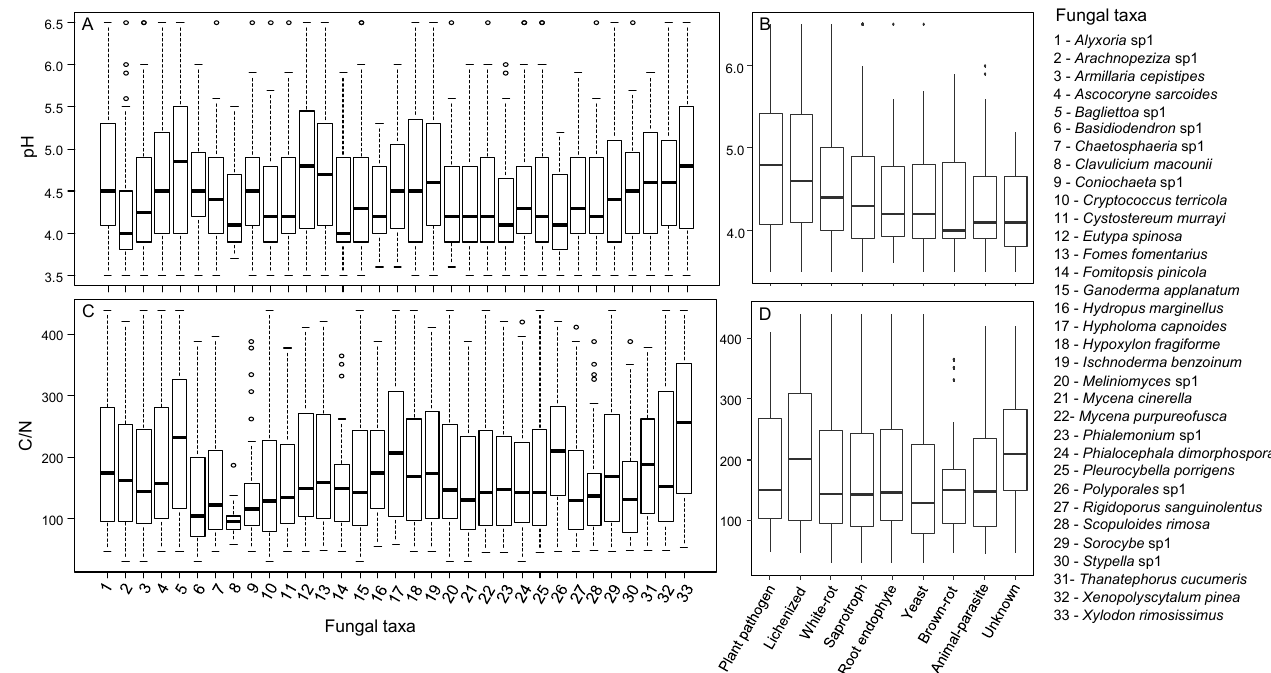
Figure 6. Values of pH ( A , B ) and C/N ( C , D ) for 33 dominant fungal taxa from the Salajka natural forest (left column) showing at least one significant effect among pH, C/N and their interaction. These taxa were classified at the ecological group level (right column).